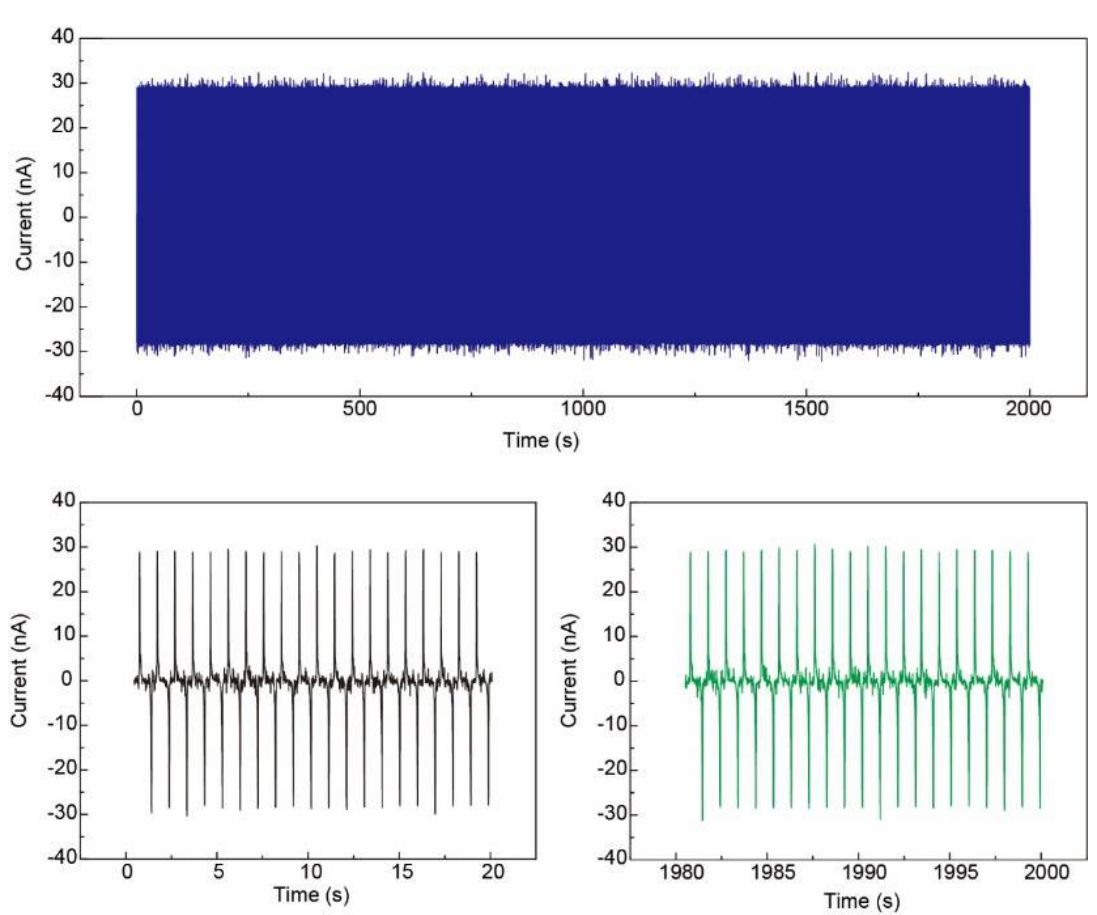
Figure 9. Top : output current for 2000 s (~2000 cycles) to show the stability of the Ag NFs electrode based pressure sensor array. Bottom : output voltage of the beginning and the end of the test. The output current of one contact–separate cycle kept about 30 nA.